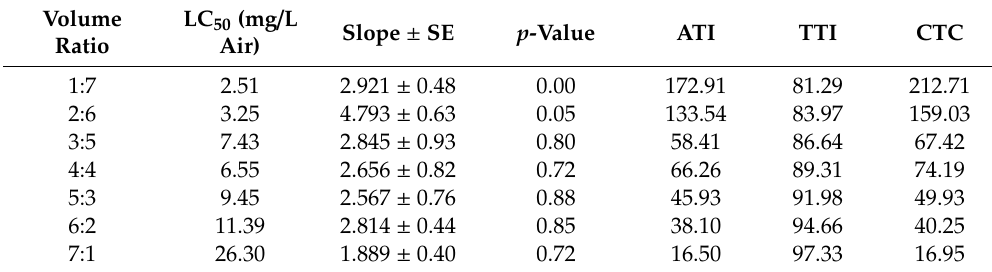
Table 6. Fumigant toxicity and CTC of carvone and limonene mixture against adult of T. castaneum . Volume